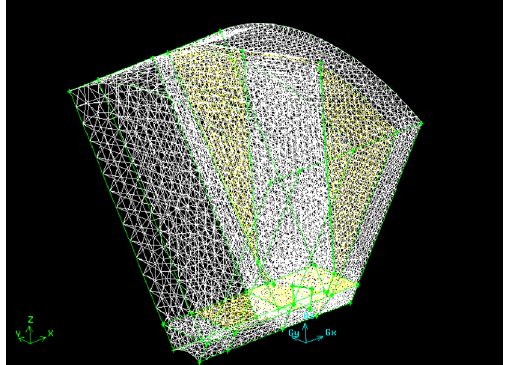
Figure 10: Mesh generation for a single blade used in FLUENT sim- ulation.